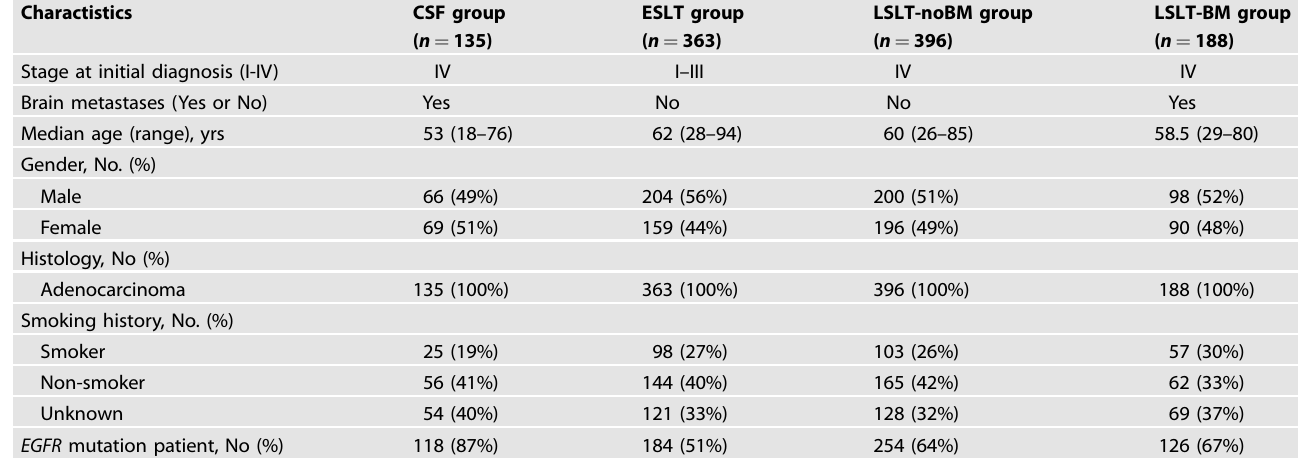
Table 1. Characteristics of samples between different groups in this